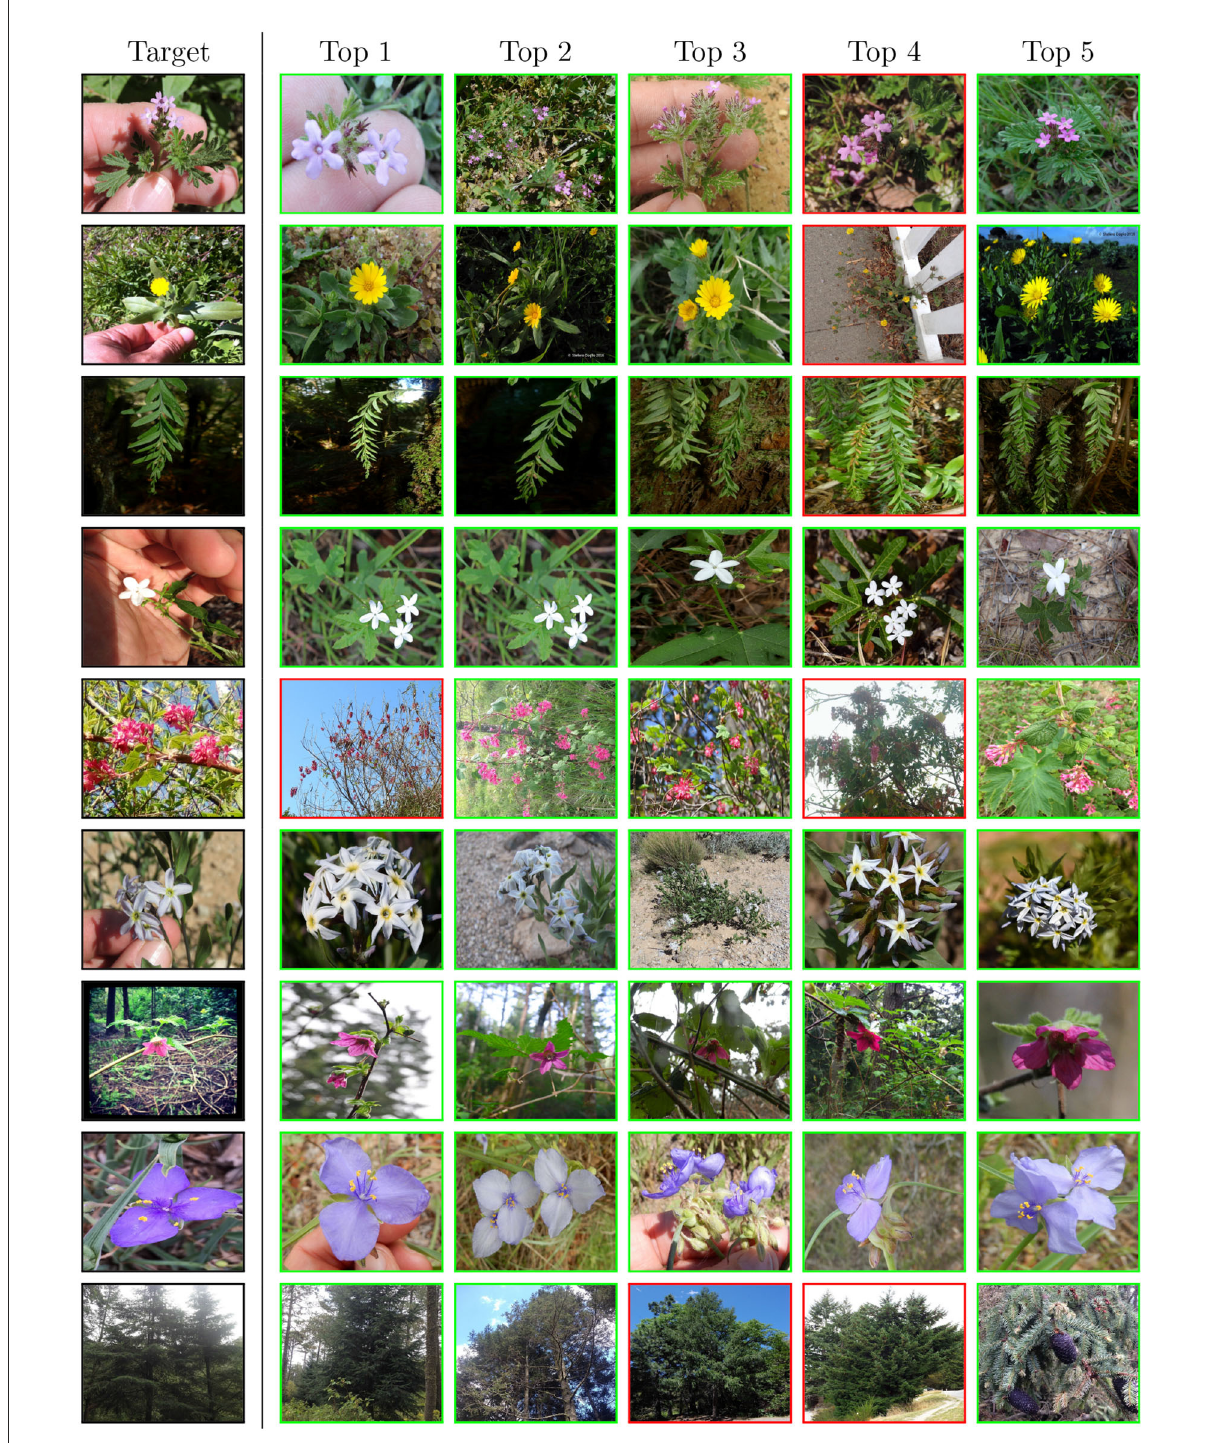
FIGURE5 Qualitative examples from the retrieval approach on the iNaturalist dataset. The leftmost column shows samples from the test set followed by five nearest neighbors in the learned embedding space from the training set. The red box denotes the wrong species.